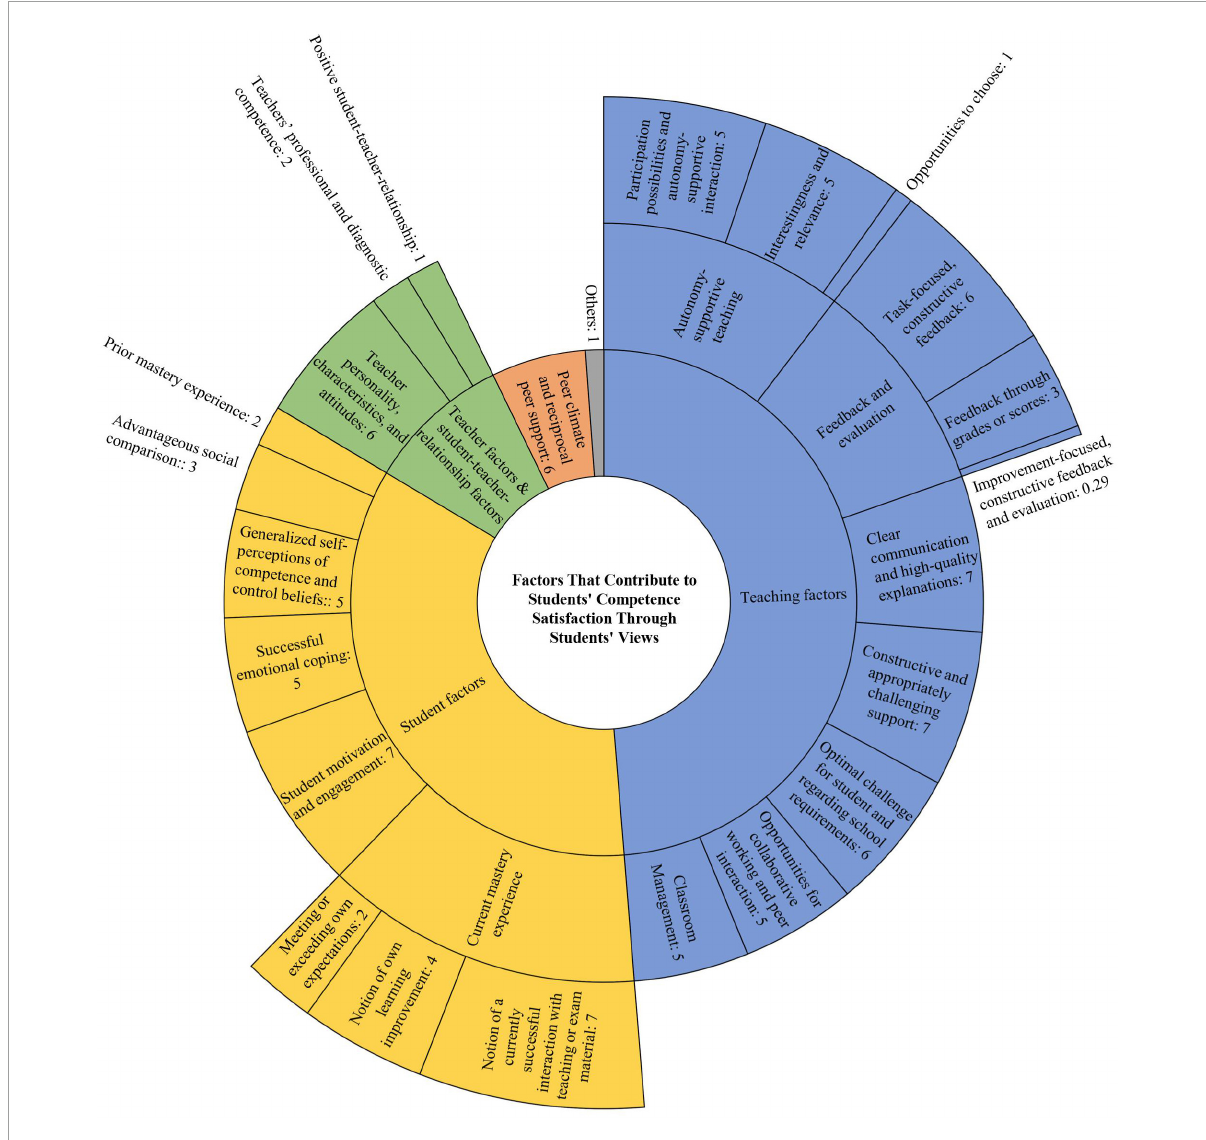
FIGURE2 Relative category distribution of the factors that contribute to students’ competence satisfaction through students’ perspectives. The relative category distribution represents n % of all category codings, based on the absolute person frequencies (i.e., n students that have addressed the respective categories at least in one segment and at least from the perspective of one coder; see Table 1 ). The relative category distributions sum up to 101.29% instead of 100% because, for the sake of clarity, all values have been rounded to the nearest whole number, with one exception. The relative distribution of the category “Improvement-focused, constructive feedback and evaluation” has been rounded to two decimal places in order not to create the impression that its value is